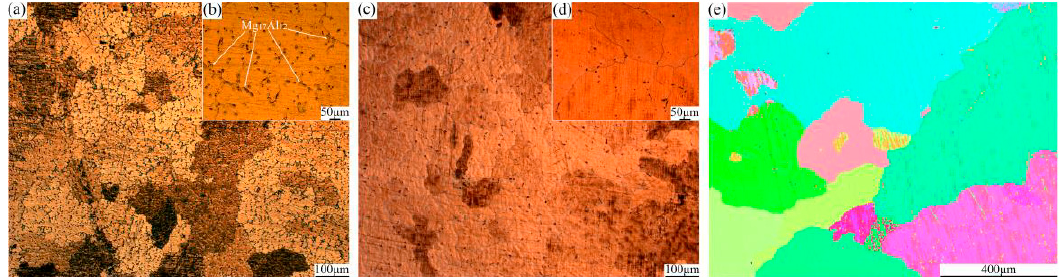
Figure 3. Microstructures of ( a , b ) as-cast: ( a ) OM images, ( b ) enlarged in ( a ); and ( c – e ) as-homogenized AZ31 alloys: ( c ) OM image, ( d ) enlarged in ( c ), ( e ) IPF image.